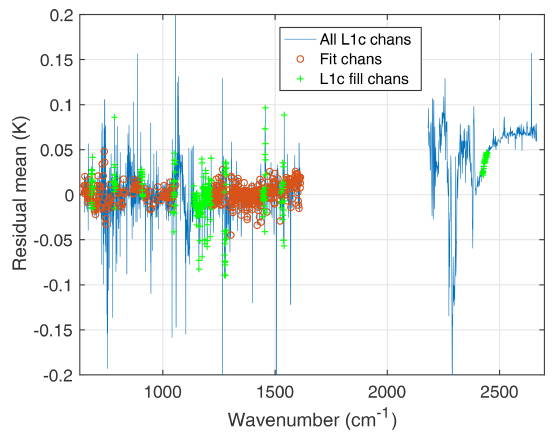
Figure 8. Anomaly fit residual, averaged over all 365 16d time steps for ± 30 ◦ latitude. The L1c fill channels have no L1b counter- parts and are simulated in the production of L1c. Note the offset in the